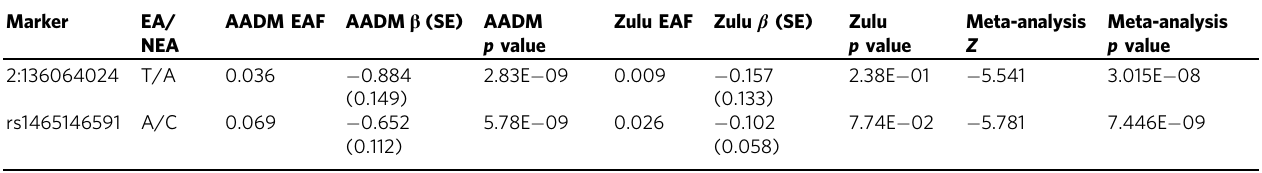
Table 2 Association tests for the ZRANB3 T2D locus in AADM discovery ( n = 5231) and Zulu replication ( n = 2578) studies Marker